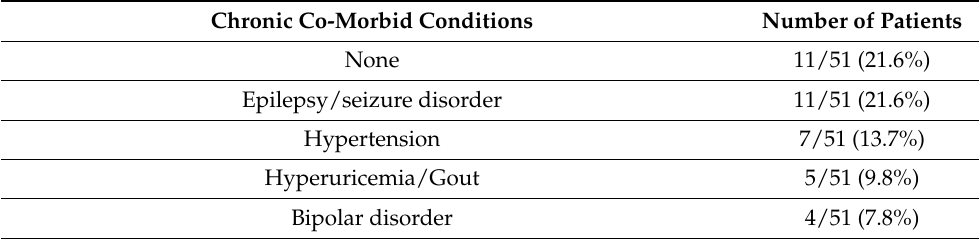
review. Patients who had no comorbidities were given the culprit drug for an acute disease (i.e., infection, pain, acne, etc.). Multiple patients had multiple